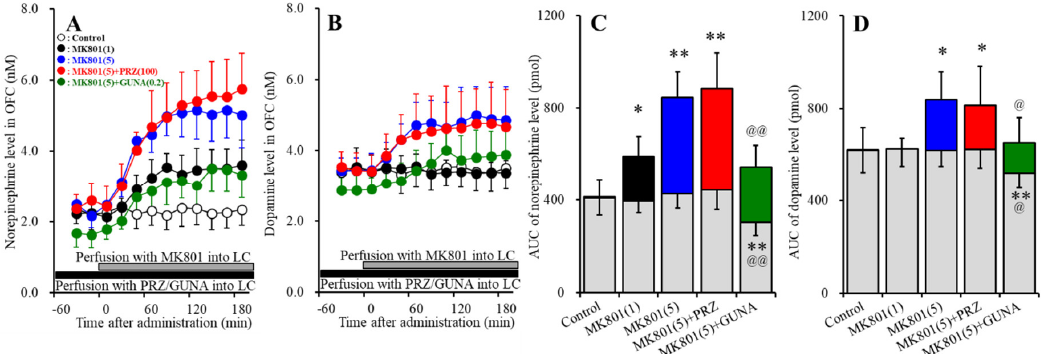
Figure 1. Effects of local administration of prazosin (PRZ) and guanfacine (GUNA) into the locus coeruleus (LC) on dizocilpine (MK801)-induced releases of norepinephrine ( A ) and dopamine ( B ) in the orbitofrontal cortex (OFC). Ordinates: mean ± standard deviation (SD) (n = 6) of extracellular catecholamine levels (nM); abscissa: time after MK801 administration (min). Black bars indicate perfusion with 100 µ M prazosin (PRZ) or 0.2 µ M guanfacine (GUNA) into the LC. Gray bars indicate perfusion with 1 µ M or 5 µ M MK801 into the LC. ( C , D ) indicate the area under curve (AUC) values of extracellular levels of norepinephrine and dopamine (pmol) after perfusion with MK801 (from 20 to 180 min), based on ( A ) and ( B ), respectively. Gray columns represent the AUC values before perfusion with MK801 (basal release). * p < 0.05, ** p < 0.01; relative to control, @ p < 0.05, @@ p < 0.01; relative to MK801 (5 µ M) by MANOVA with Tukey’s post hoc